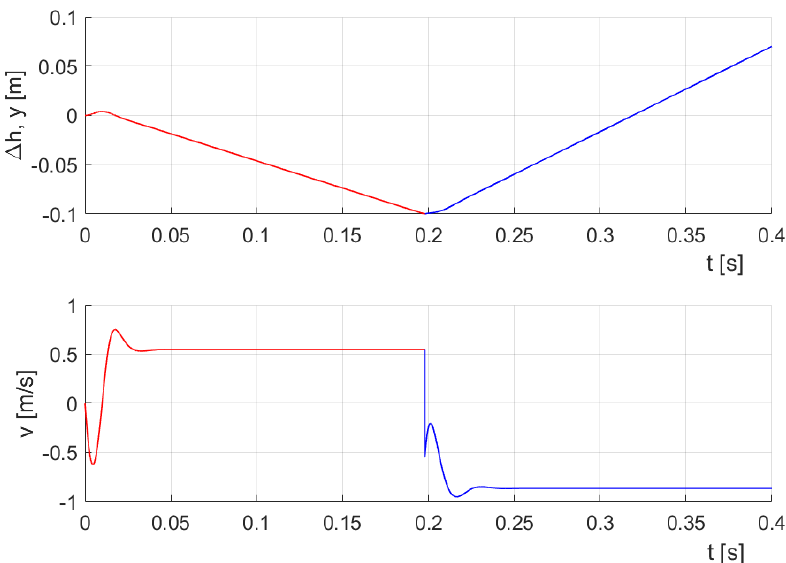
Figure 9. Displacement y ( t ) and speed v( t ) of the working plunger.